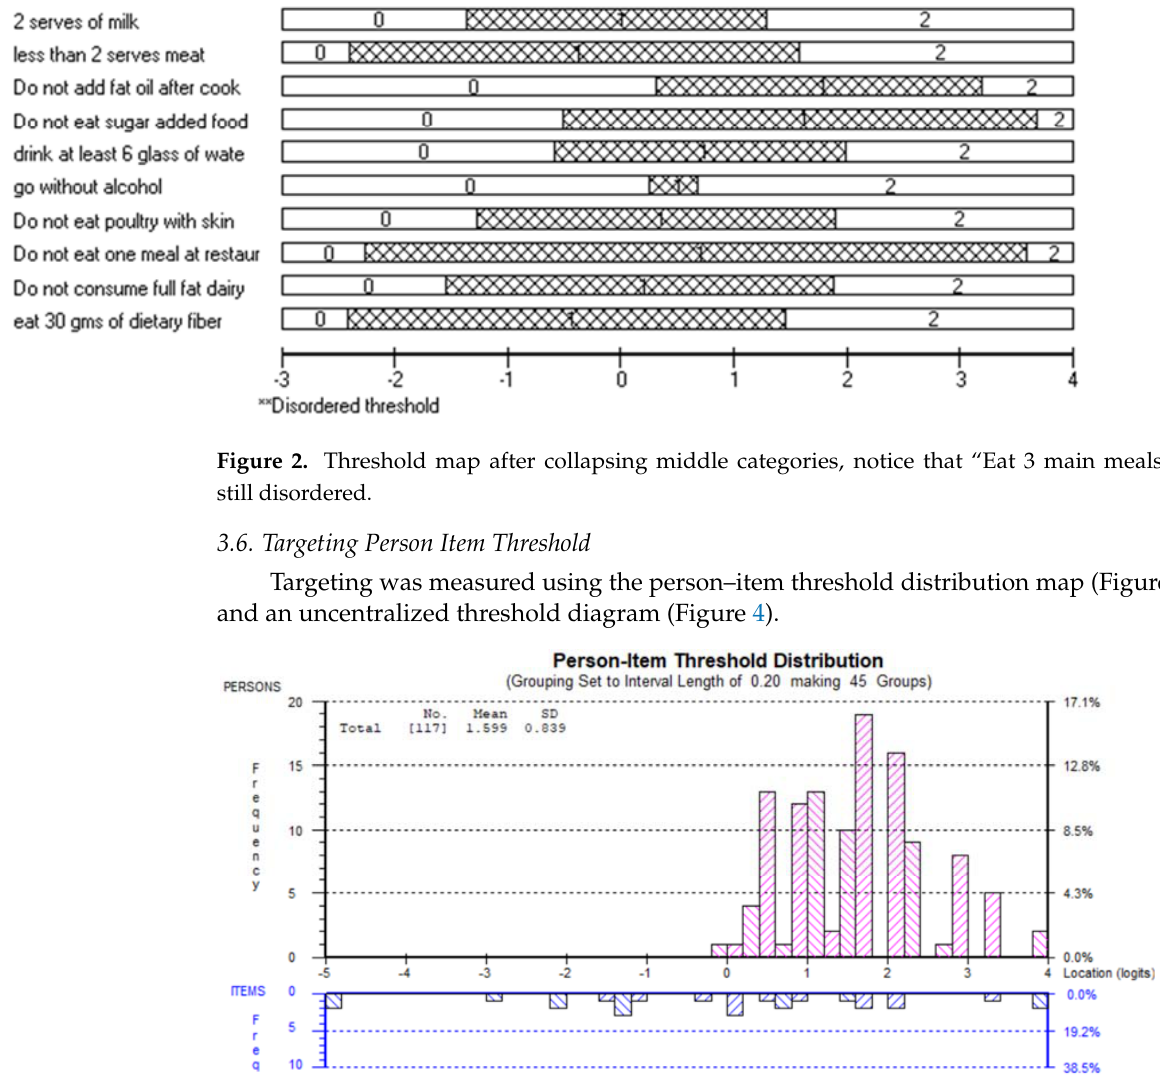
Figure 3. Person–item threshold distribution.